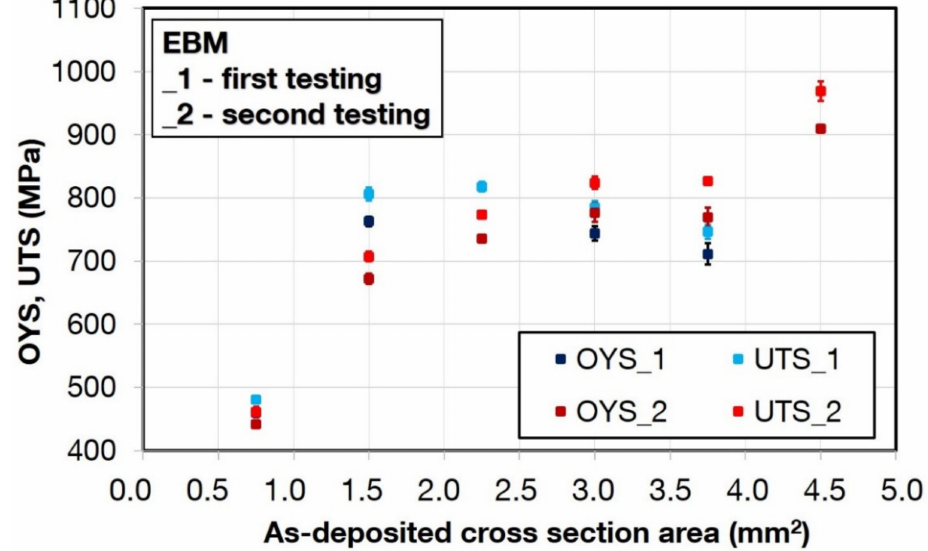
Figure 14. Average strength values obtained from the first (“1”) and the second (“2”) batch of testing EBM-processed